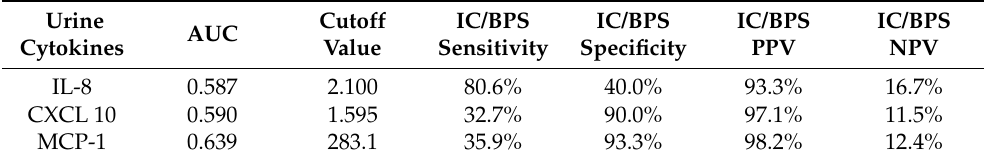
Table 5. Receiver operating characteristic analysis results of each urinary biomarker for predicting interstitial cystitis/bladder pain